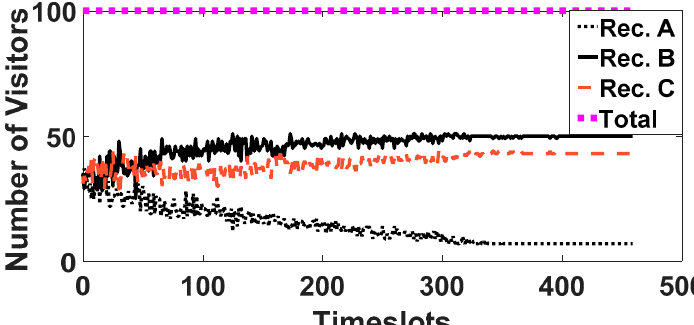
Figure 4. Convergence of RSVTM algorithm to the recommendation selections as a function of the timeslots.